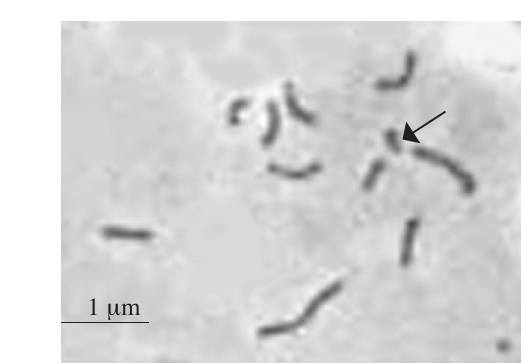
Fig. 3 - Normal metaphase kryotype from embryonic cells of Grape phylloxera: 2n= 10 + small chromosome (the arrow).